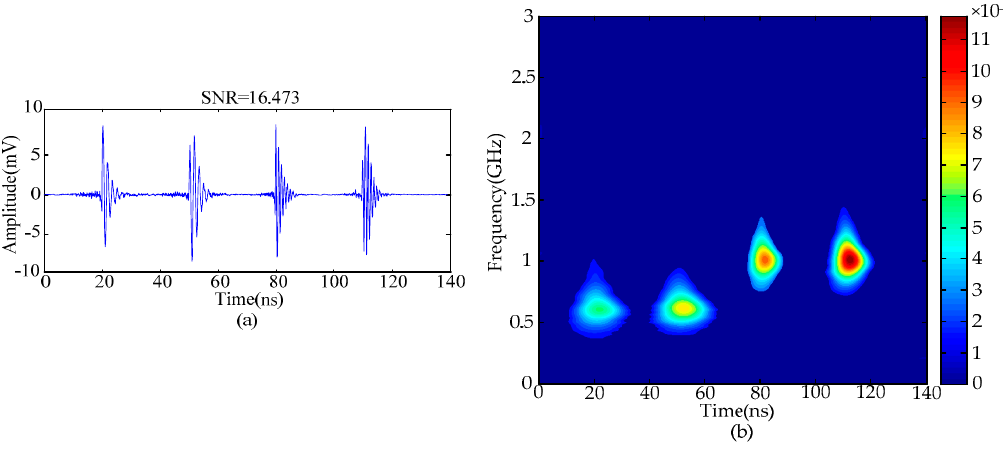
Figure 8. De-noised PD signals: ( a ) time-domain signals; ( b ) time-frequency distribution.